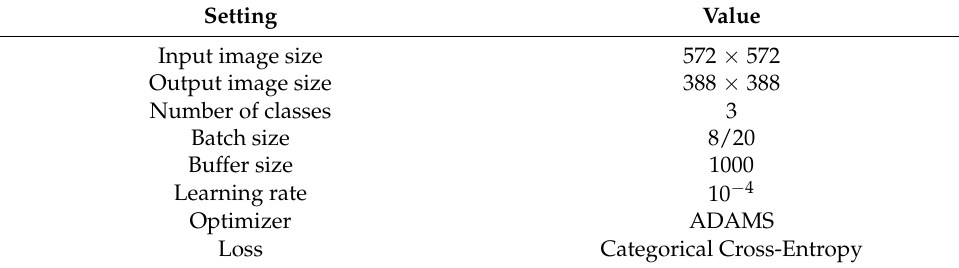
Table 3. Training settings for